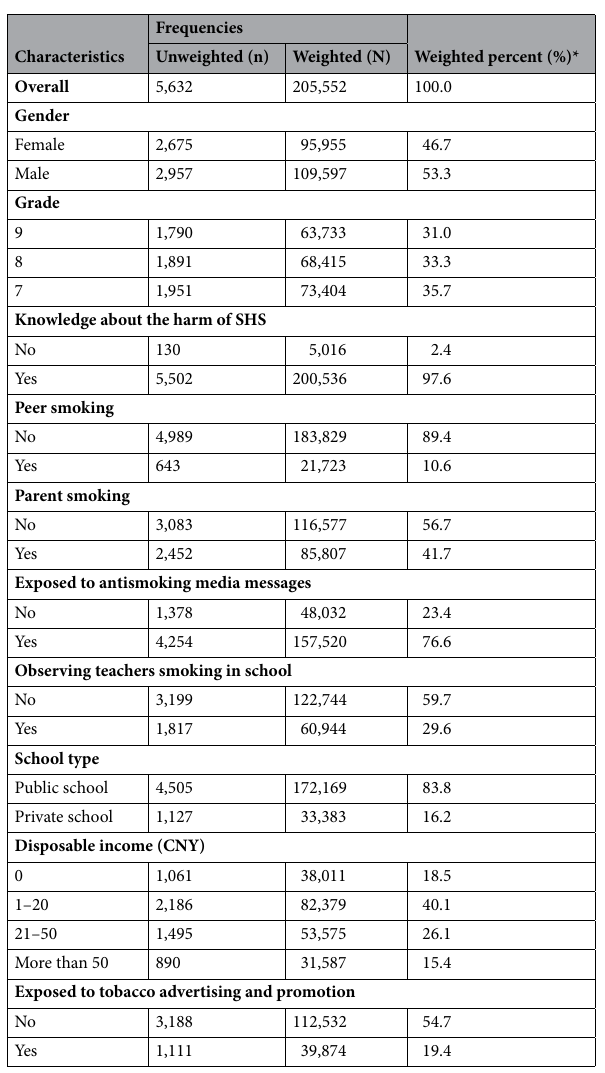
Table 2. Demographic characteristics of secondhand smoke (SHS) exposure among never-smoking adolescents, in Wuhan, China. CNY Chinese Yuan, 1 United States dollar = 6.7 Chinese yuan. *The percentages don’t add to 100 due to missing